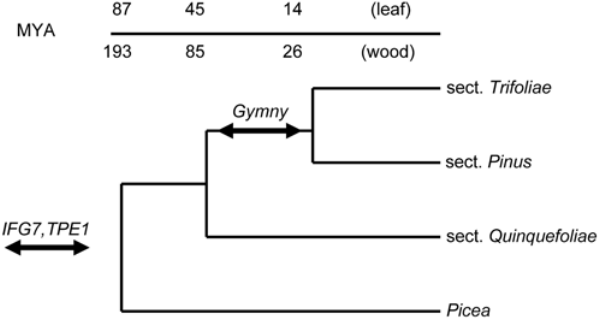
Figure 6. Monophyletic lineages within the genus Pinus , with hypothesized time frame for amplification or introduction of Gymny elements into the subgenus Pinus lineage relative to IFG7 and TPE1. The tree shown is derived from the analyses performed by Willyard et al. [12] where the dates for the nodes were selected to show the maximum possible range of values using either wood or leaf fossil calibrations, and either nuclear DNA or chloroplast DNA